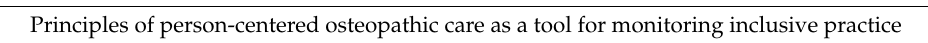
Table 2. Overarching theme, themes, and